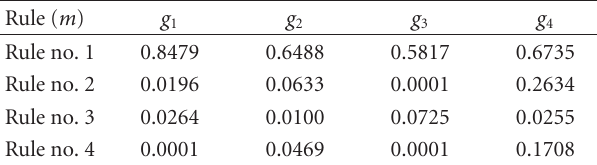
Figure 5: Lattice of fuzzy measure values of the constituent singleton sets of rule no.1 of Table 10 for industrial dryer’s data. Table 14: Fuzzy densities using GMM.